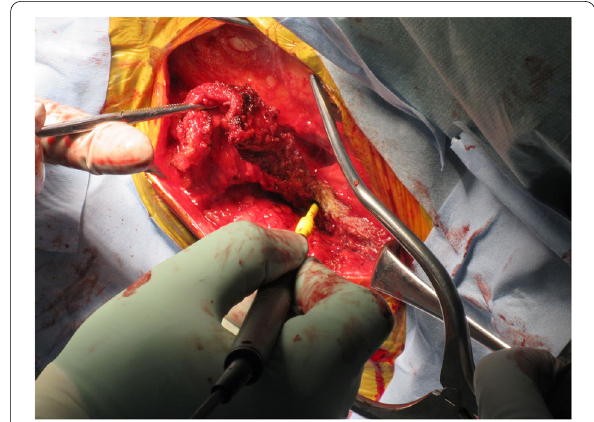
Fig. 1 Harvesting the tensor fascia lata. The tensor fascia lata of the contralateral thigh was harvested in this patient